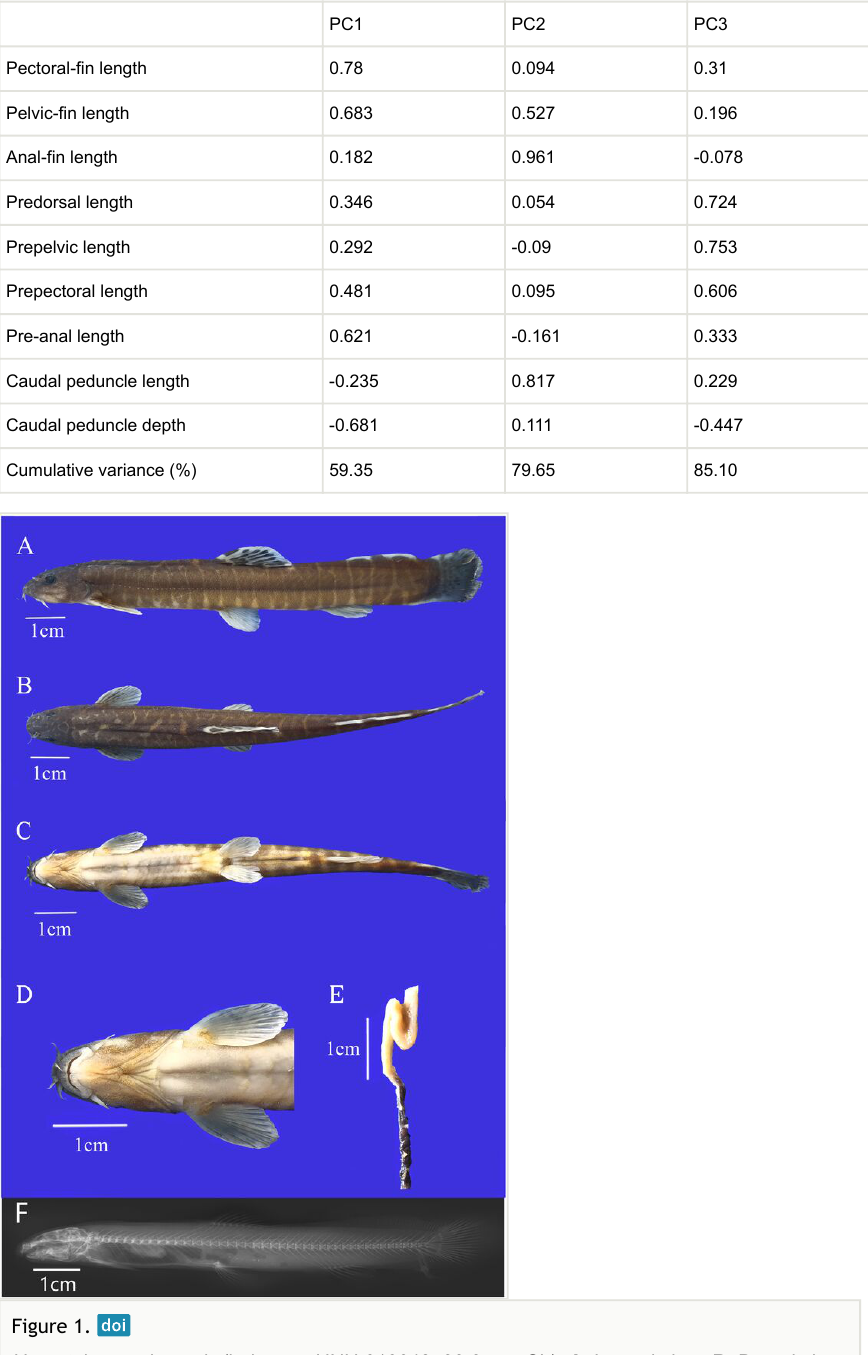
Figure 1. Homatula guanheensis (holotype, HNU 010048, 99.6 mm SL). A. Lateral view; B. Dorsal view; C. Ventral view; D. Mouth characters; E. Intestine form; F. X–ray (lateral